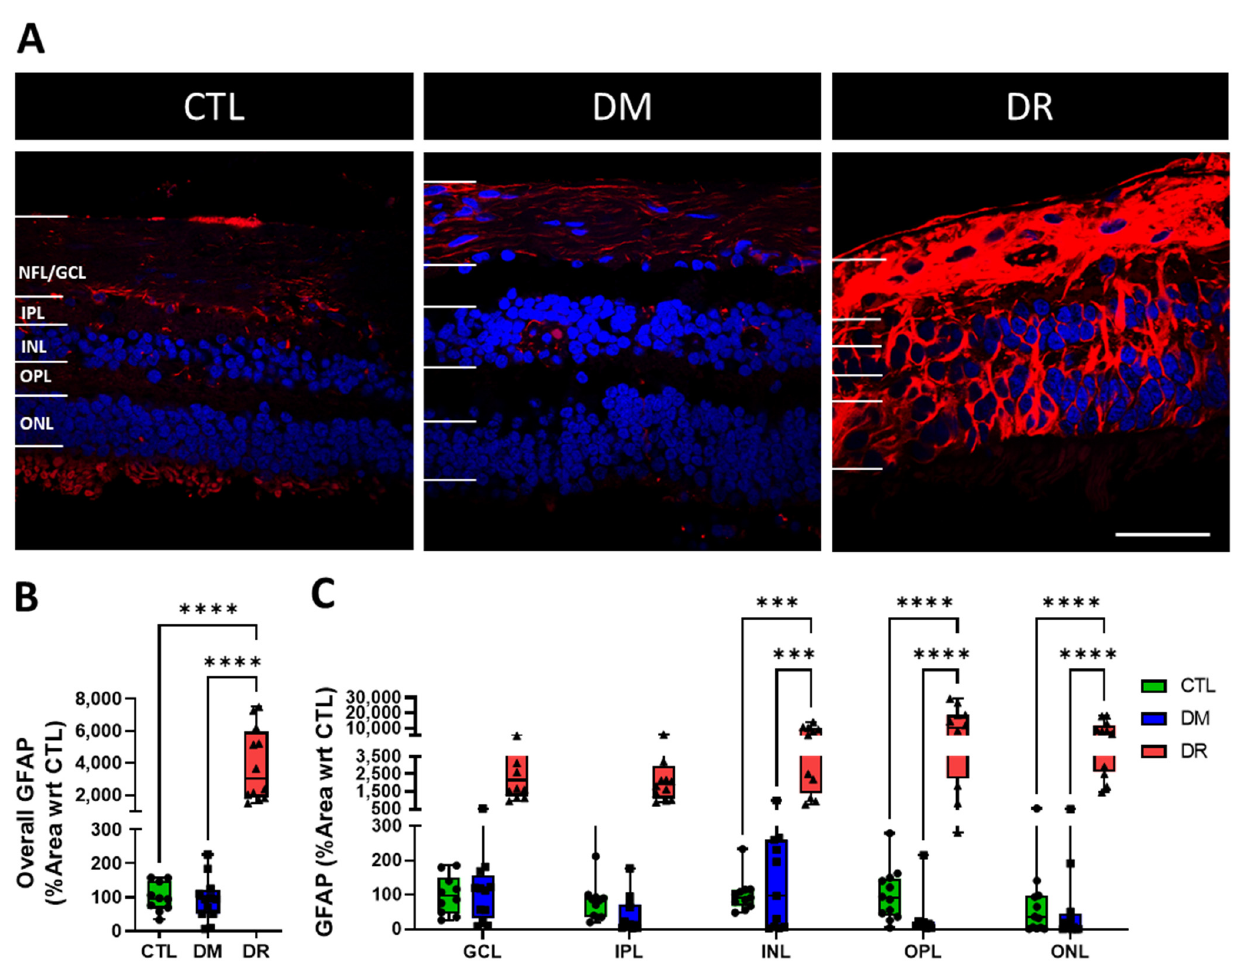
Figure 2. GFAP expression was significantly increased in DR. ( A ) Immunohistochemical images show that GFAP (red) was minimally expressed in CTL and DM in the NFL/GCL, IPL and INL, but significantly increased in all retinal layers in DR. ( B ) Quantification of GFAP expression in the entire retina showed low levels of GFAP expressed in CTL and DM, while significantly higher levels were found in DR compared to CTL ( p ≤ 0.0001) and DM ( p ≤ 0.0001). ( C ) Quantification by each retinal layer showed GFAP expression was significantly higher in DR compared to CTL and DM in the INL ( p ≤ 0.001), OPL ( p ≤ 0.0001) and ONL ( p ≤ 0.0001). Scale bar = 50 µm. *** p ≤ 0.001; **** p ≤ 0.0001. Statistical analysis was carried out using one-way ANOVA for expression in the entire retina and two-way ANOVA for expression in each retinal layer. Data point of each patient in CTL, DM and DR are marked as circle, square and triangle, respectively.